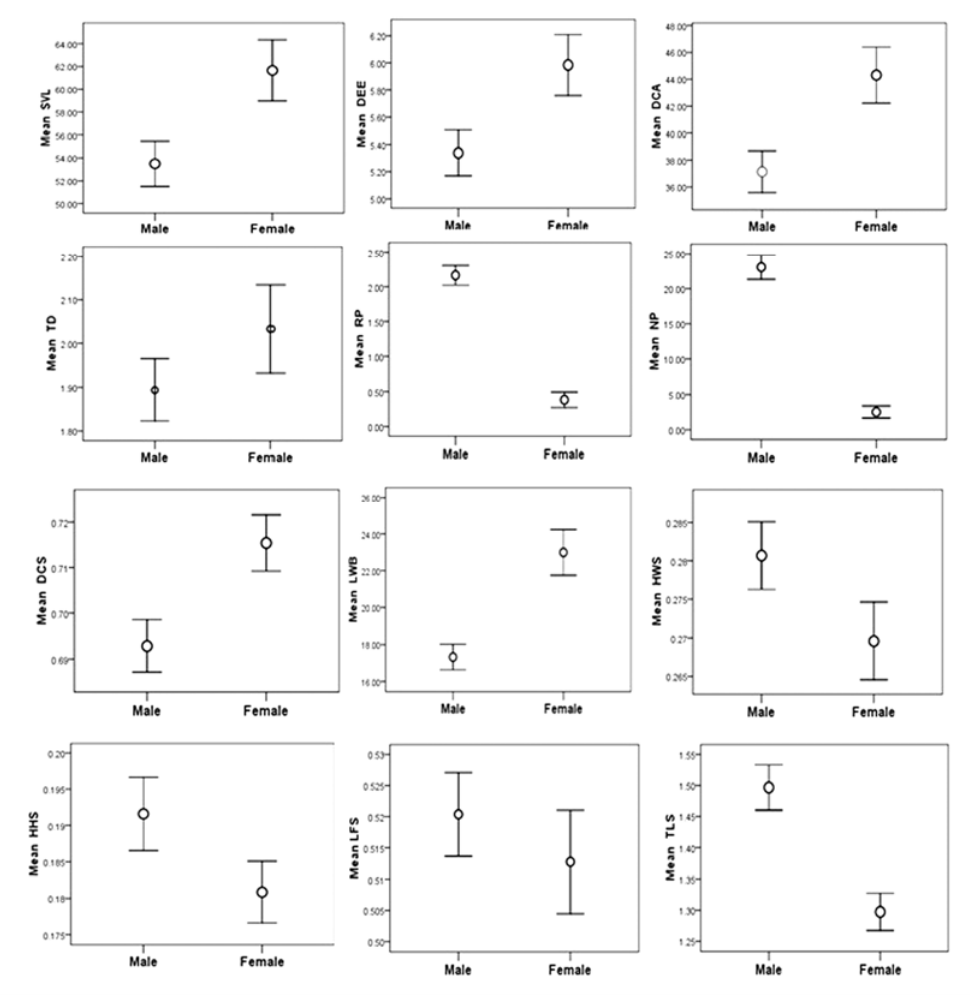
F IGURE 2. The mean and standard error for significantly different characters between males and females of T. lessonae revealed from the Analysis of Variance